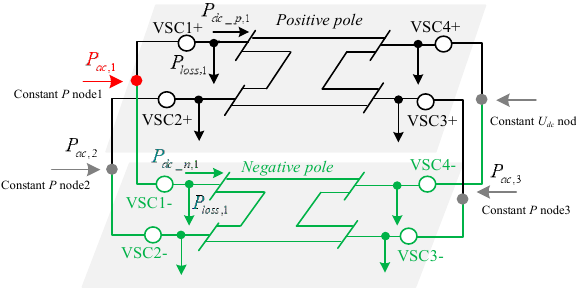
Figure 3. The nodal equivalent diagram of a bipolar VSC-MTDC.